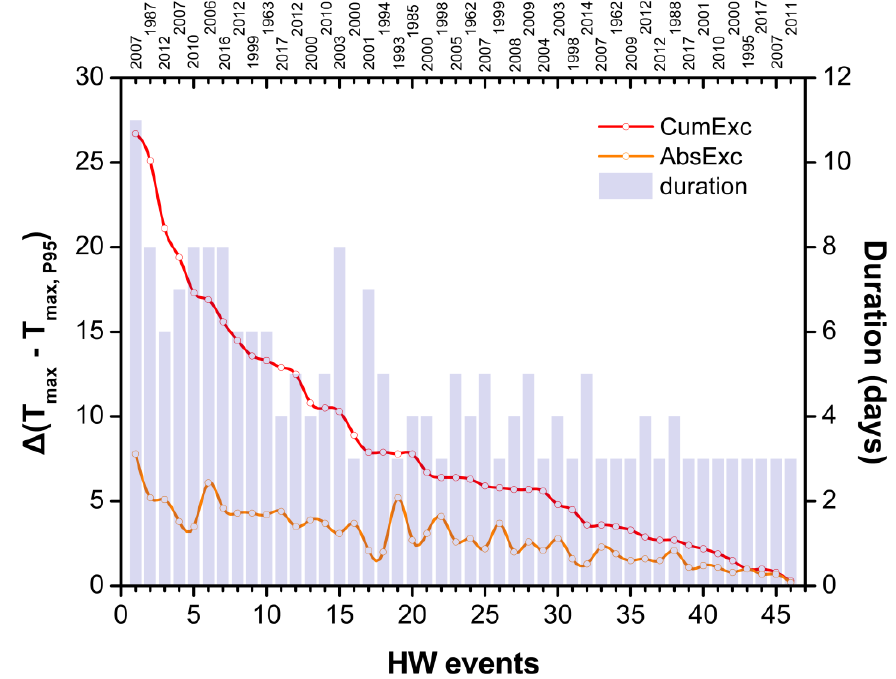
Figure 3. Difference between the T max and the 95th T max percentile threshold expressed as cumulative exceedance (CumExc), defined as the sum of the differences for all days of the HW episode, and as absolute exceedance (AbsExc), defined as the maximum daily difference during the HW episode, organized in descending order of T max cumulative exceedance. The duration and the year of appearance are also depicted for each of the 46 HW events of the 1960 – 2017 period, organized in descending order of T max cumulative exceedance (CumExc).